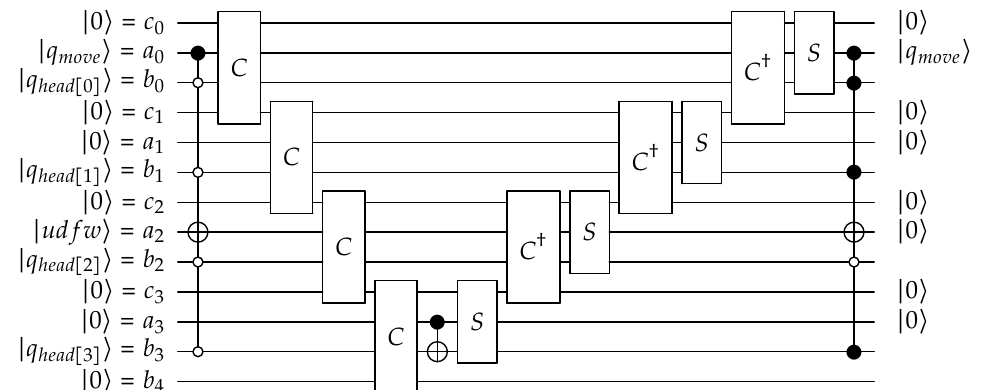
Figure A6. Modulo-12 quantum subtractor for implementing move tape head for QPULBA 2-2-1. Both the increment and decrement circuits can be simplified considering some of the control qubits are always in the 0 state, so those CNOT/Toffoli gates can be ignored. Reset : Quantum logic is universal and can implement any classical Boolean logic func- tion using only the Toffoli (CCNOT) or Fredkin (CSWAP) gate. However, it is not always possible to uncompute all ancilla qubits. Specifically, if the function to be implemented is irreversible. However, for the QPULBA case, we intend to evolve a superposition of all possible classical functions/programs C f that can be represented by the description number en- coding. These functions include both reversible as well as irreversible functions, thus, we cannot uncompute away the computation history of the state transition. Both the state and the read together preserve the evolution history. Thus, we need ancilla qubits in each step of the computation that would hold the transition history for the QPULBA. This limits the number of steps of the QPULBA we can implement or simulate. Besides the state and read, the write and move qubits need to be reset in each cycle. This is implemented by calling the FSM transition function once again with the previous state and the